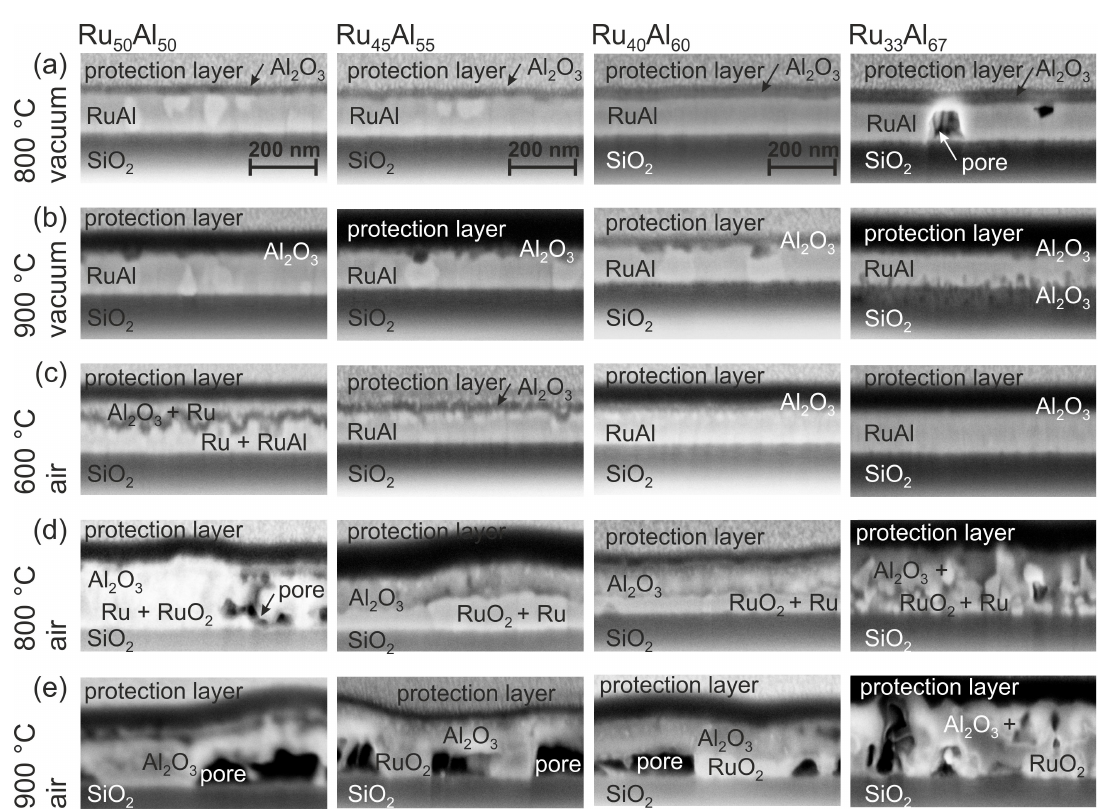
Figure 3. SEM inLens images (3 kV) of the focussed ion beam (FIB) cross sections of the samples with the different compositions Ru 50 Al 50 , Ru 45 Al 55 , Ru 40 Al 60 and Ru 33 Al 67 after heat treatment for 10 h at ( a ) 800 ◦ C; ( b ) 900 ◦ C under high vacuum, as well as ( c ) 600 ◦ C; ( d ) 800 ◦ C and ( e ) 900 ◦ C in air. The images are labeled according to the results of the Auger electron spectroscopy (AES) and transmission electron microscopy/energy dispersive X-ray spectroscopy (TEM/EDX)